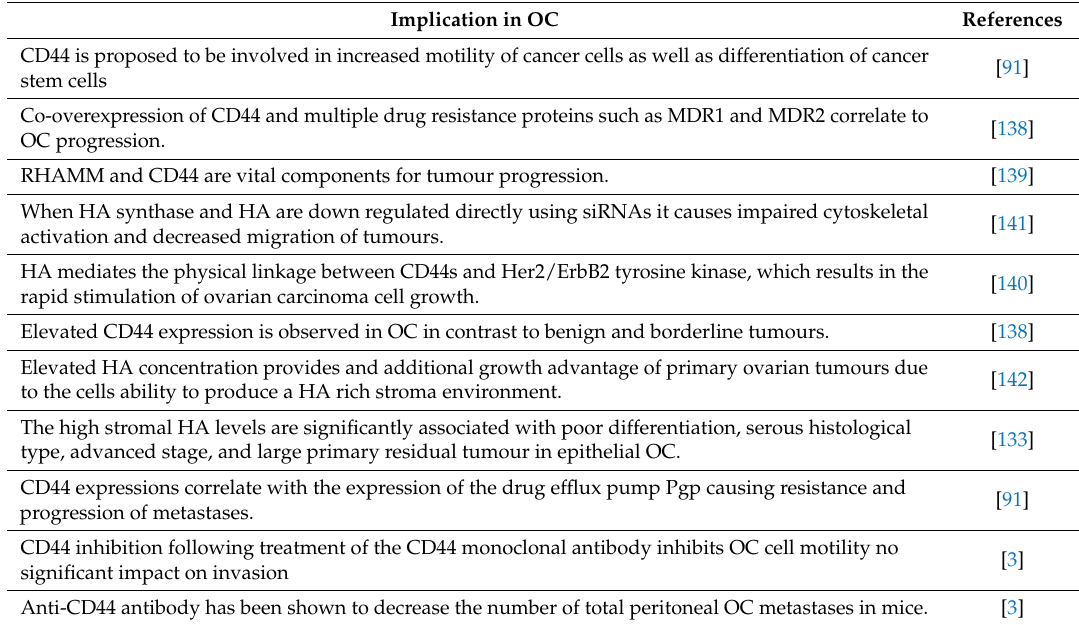
Table 5. The relationship of CD44 and HA to the ovarian cancer development. Implication in